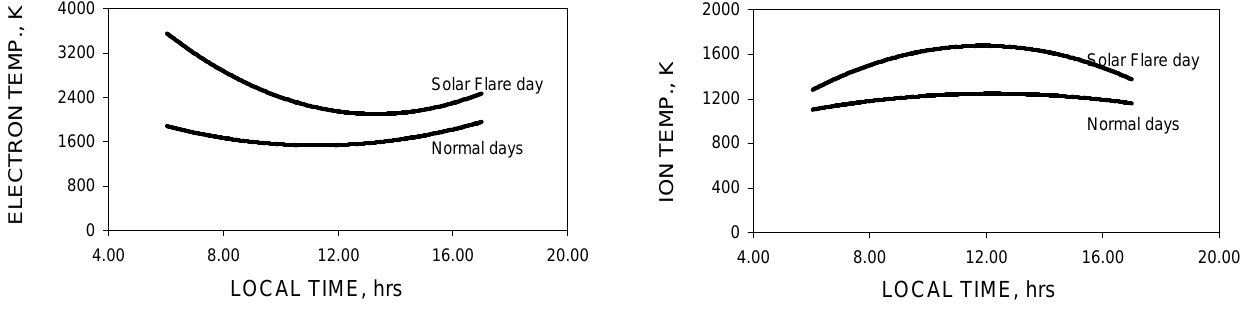
Fig. 7. Diurnal variation of average electron temperature during solar flares and normal days.